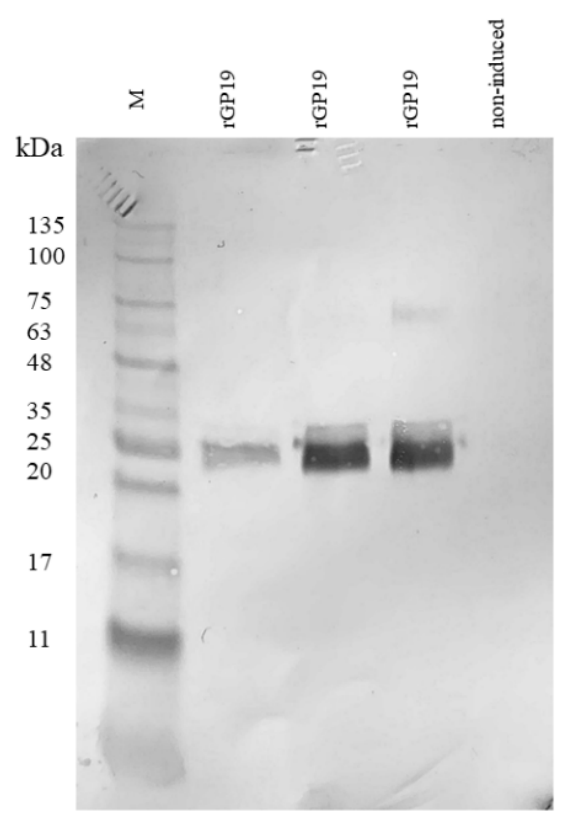
Figure 1. Recombinant protein of Ehrlichia canis (rGP19) expression was affirmed with the HRP conjugated IgG antibody against rGP19 in Western blot analysis. Lane M: protein marker; rGP19: recombinant protein GP19 induced with IPTG; non-induced: non-induced rGP19 with IPTG.